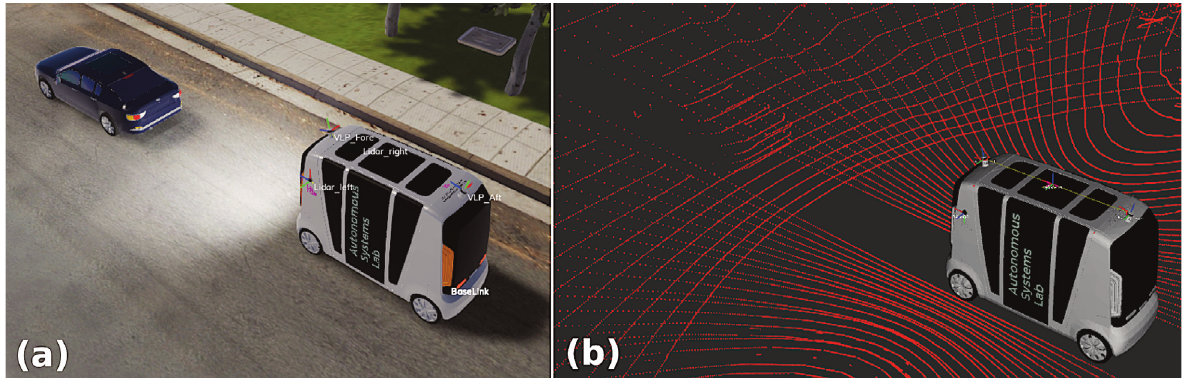
Fig. 5. (a) SVL environment versus (b) Rviz point-cloud visualization.